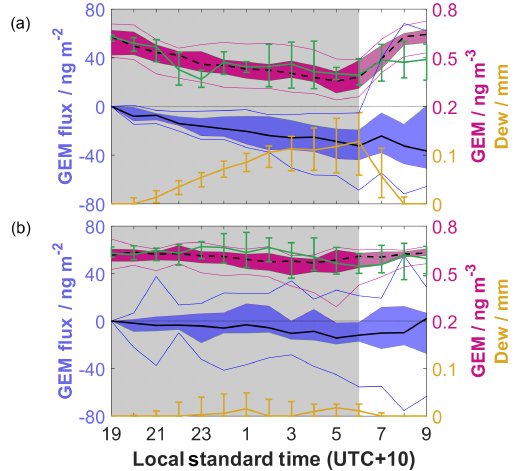
Figure 5. (a) Nocturnal composites for dew nights. Solid black line represents median cumulative GEM flux, blue shading inter- quartile range (IQR), and blue lines 5th and 95th percentile. Black broken line represents ambient GEM, magenta shading IQR, and magenta lines 5th and 95th percentile. Green line and error bars rep- resent median modelled ambient GEM and IQR. Yellow lines and error bars represent median modelled dew depth and IQR. Note the change in scaling on the right axis. (b) As above but for non-dew